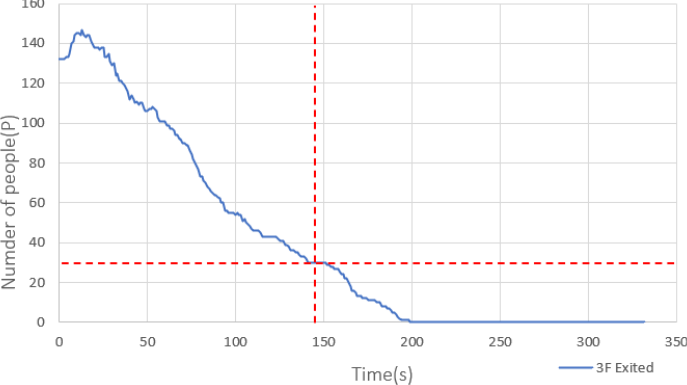
Figure 8. Front room of the escape ladder on the third floor at the 148th second.